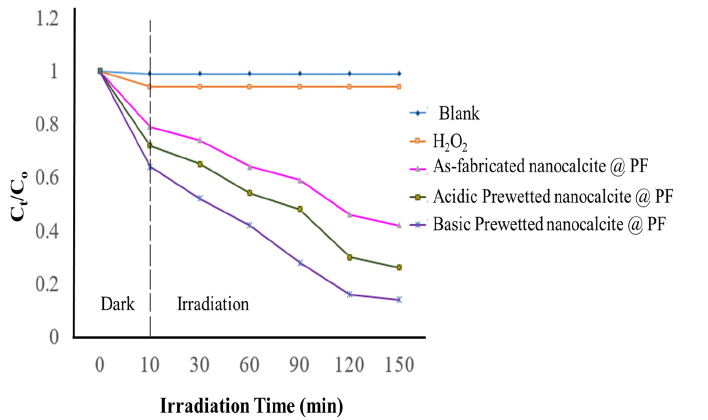
Figure 10. Determination of the extent of photocatalytic degradation (C t /C o ) of imidacloprid (C o = 100 mg/L, concentration of hydrogen peroxide 10 mM, initial pH 7.0, (irradiation time) under natural sunlight for 150 min by using nanocalcite @ PF with respect to time.